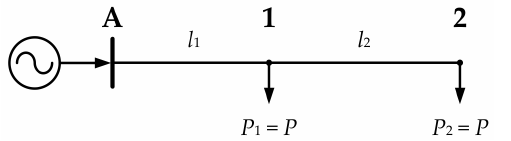
Figure 7. Radial network supplying two customers consuming the same